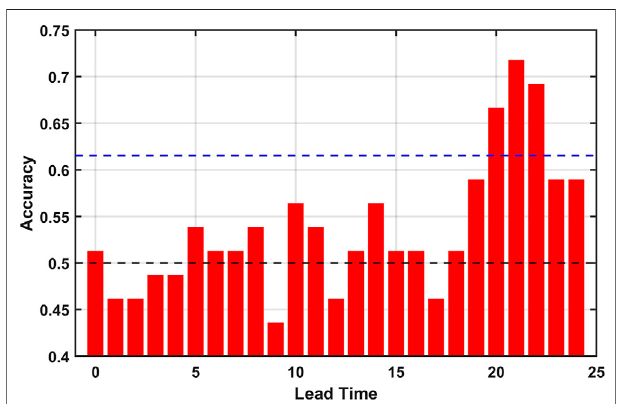
FIGURE 9 | Accuracy of predicting the wet-dry state of TRHR precipitation at varying lead times. The base skill (the null model of totally randomguess)isplottedintheblackdashedline.Theone-tailed p -value (cid:1) 0.1 signi fi cance level is estimated using bootstrapping and is plotted in the bluedashedline.Themeanaccuracyusingatotallyrandomguessstrategyfor 39 samples is collected from 10,000 repeated experiments and the 90th quantile value is used as estimation of the p -value (cid:1) 0.1 signi fi cance level.